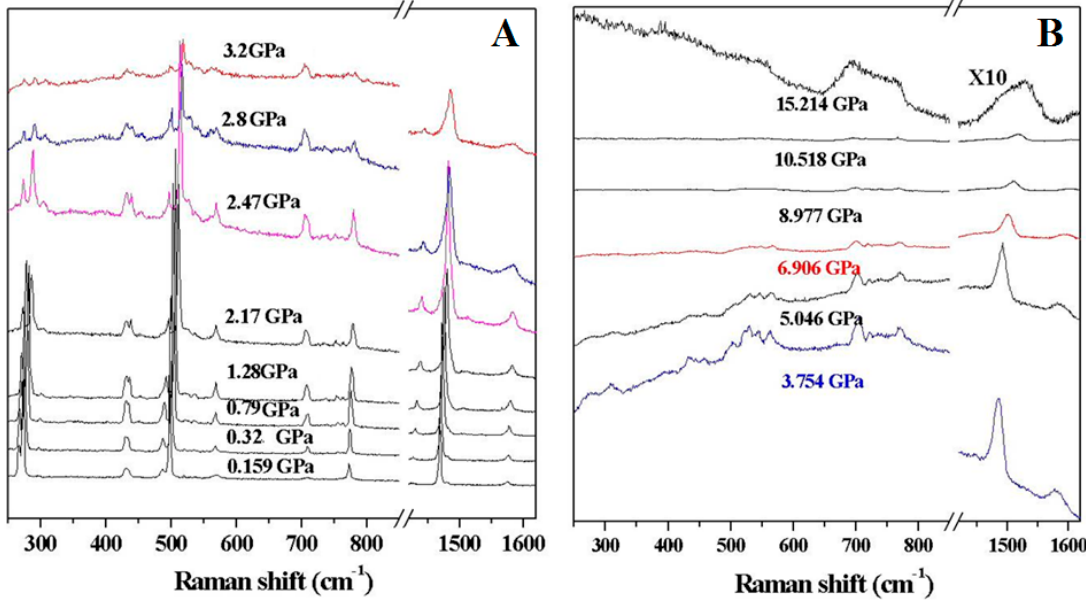
Figure 1. Raman spectra of C 60 under different pressures: low pressure range ( A ) and higher pressures ( B ).